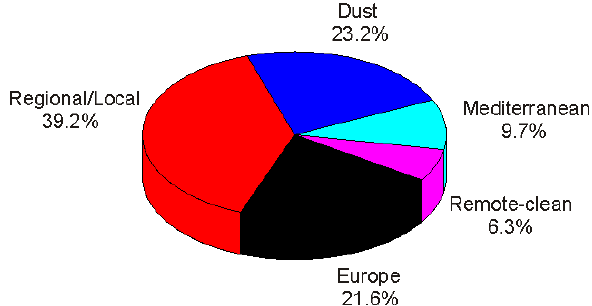
Figure 7. Contribution of discrete source areas to the average AOD taking into Fig. 7. Contribution of discrete source areas to the average AOD account the percentage time of influence and the respective AOD level. taking into account the percentage time of influence and the respec- tive AOD